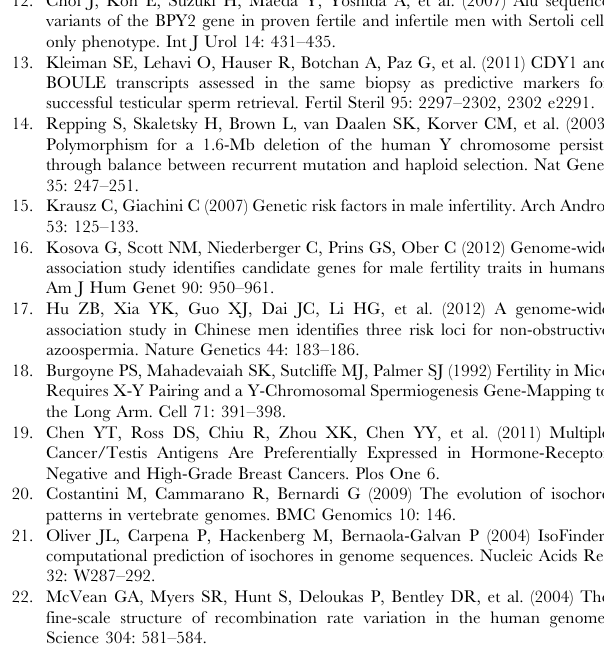
Table S2 Evolution pressure of conserved genes by